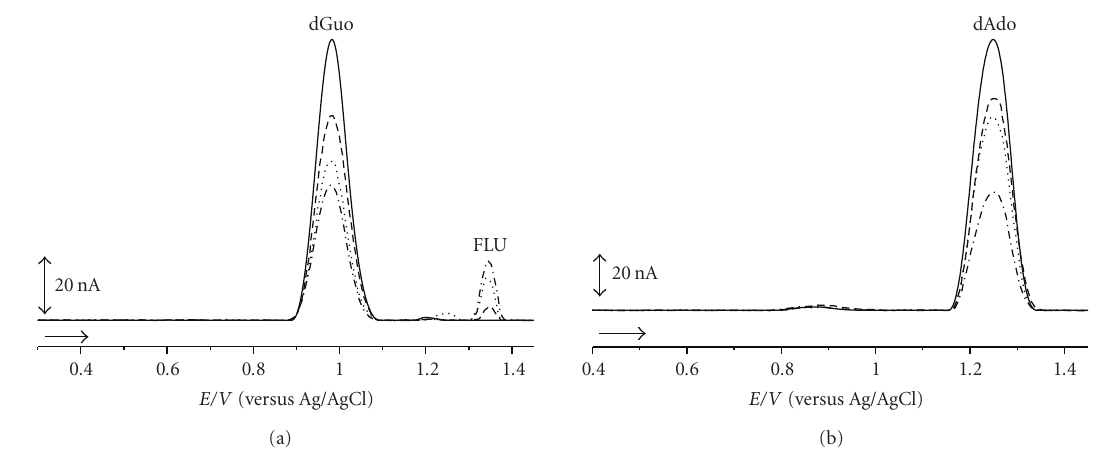
Figure 7: DP voltammograms baseline corrected in pH 4.5 0.1 M acetate bu ff er with (a) Poly[G]- and (b) Poly[A]-electrochemical biosensors (solid line) before and after incubation during (dashed line) 5min, (dotted line) 10min, and (dash-dotted line) 15min in a solution of 50 μ M FLU. Pulse amplitude-50 mV, pulse width-70ms and scan rate ν = 5mVs − 1